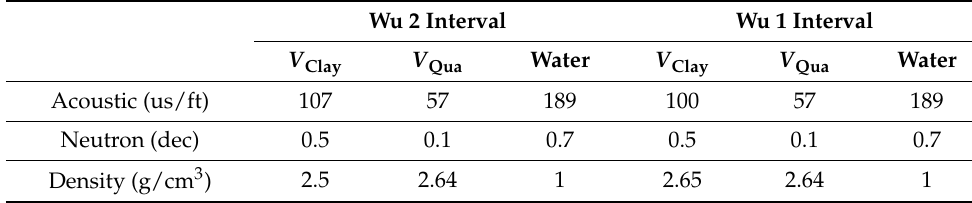
Table 1. Parameters for the volume model.